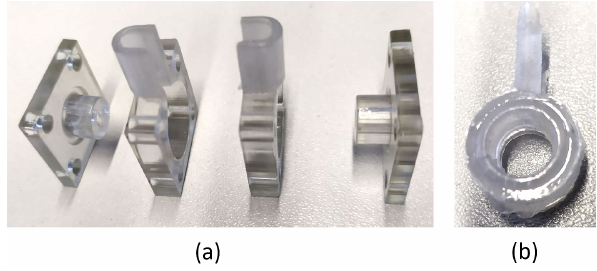
Figure 3. (a) Mold parts and (b) the cast sample chamber.